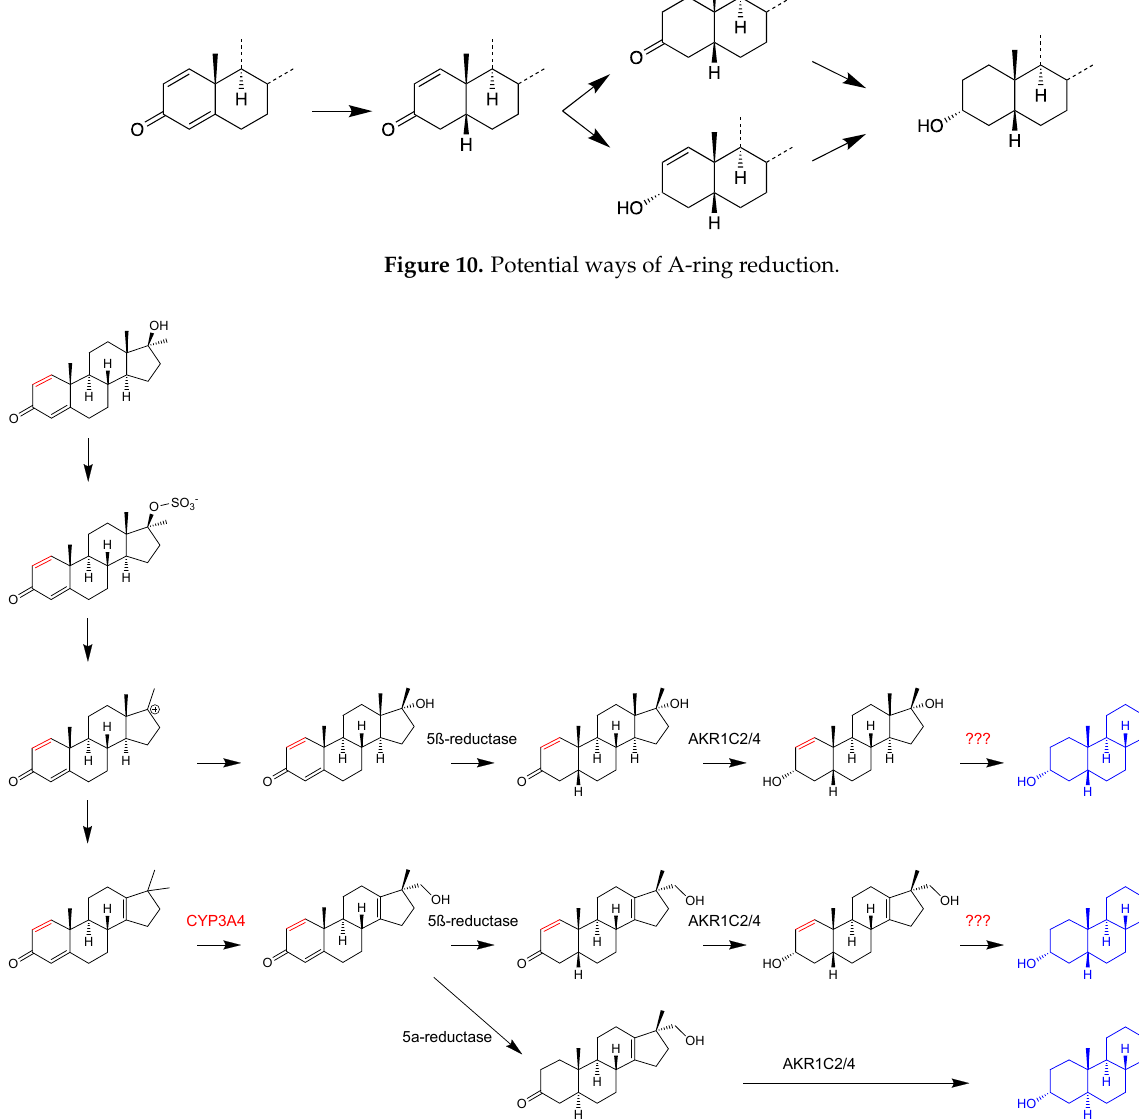
Figure 11. Proposed metabolism of methyltestosterone (black, 18 ) and metandienone (red, 12 ) to the found metabolites 17 α -hydroxymethyl-17 β -methyl-18-nor-5 β -androst-13-en-3 α -ol ( 8 ), 17 α -hydroxymethyl-17 β -methyl-18-nor-5 α -androst- 13-en-3 α -ol ( 8a ), and 17 β -methyl-5 β -androstane-3 α ,17 α -diol ( 11 ) except last step of metandienone. The question marks represent reactions whose enzymes have not been elucidated yet.